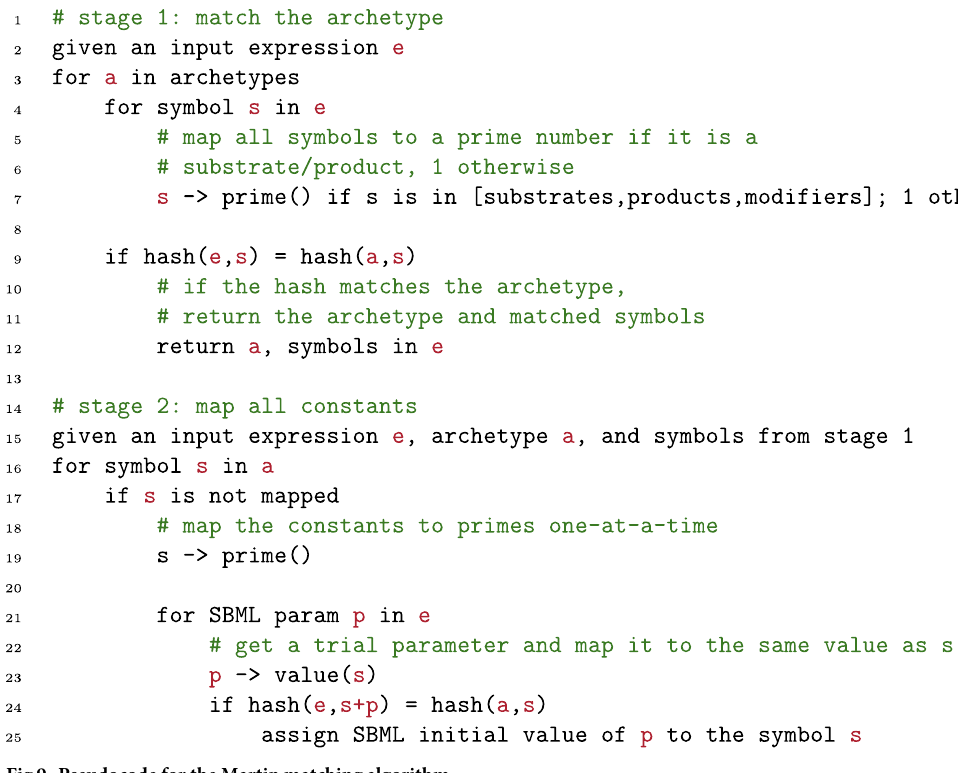
Fig 9. Pseudocode for the Martin matching